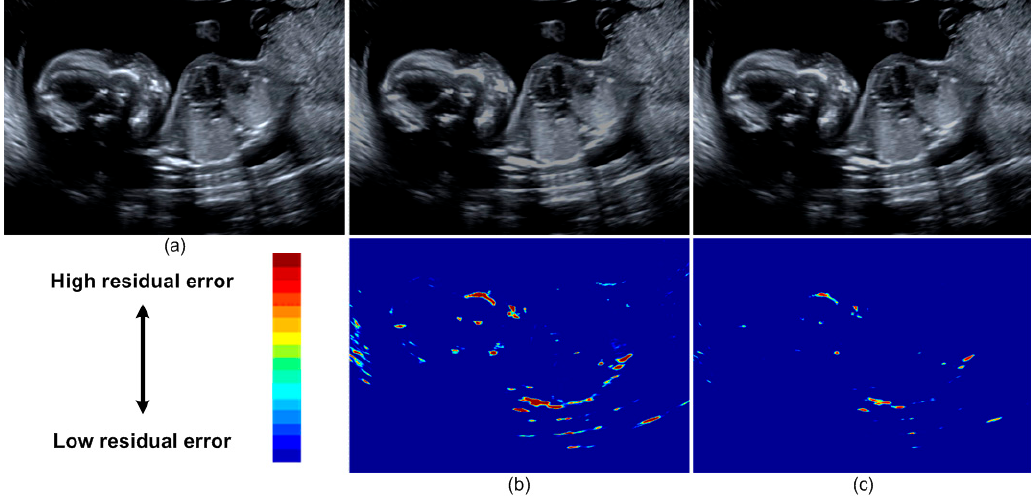
Figure 6. Quality comparison for the 21 st image of the 3 rd ultrasound image set: ( a ) original image, ( b ) images generated by I 2 GEC (PSNR: 30.104 dB, Power: 0.931 W), and ( c ) images generated by the proposed algorithm (PSNR: 36.599 dB, Power: 1.253 W) (top: result image; bottom: difference between the original and processed images). Table 1. Average and minimum PSNRs for the proposed and benchmark methods.